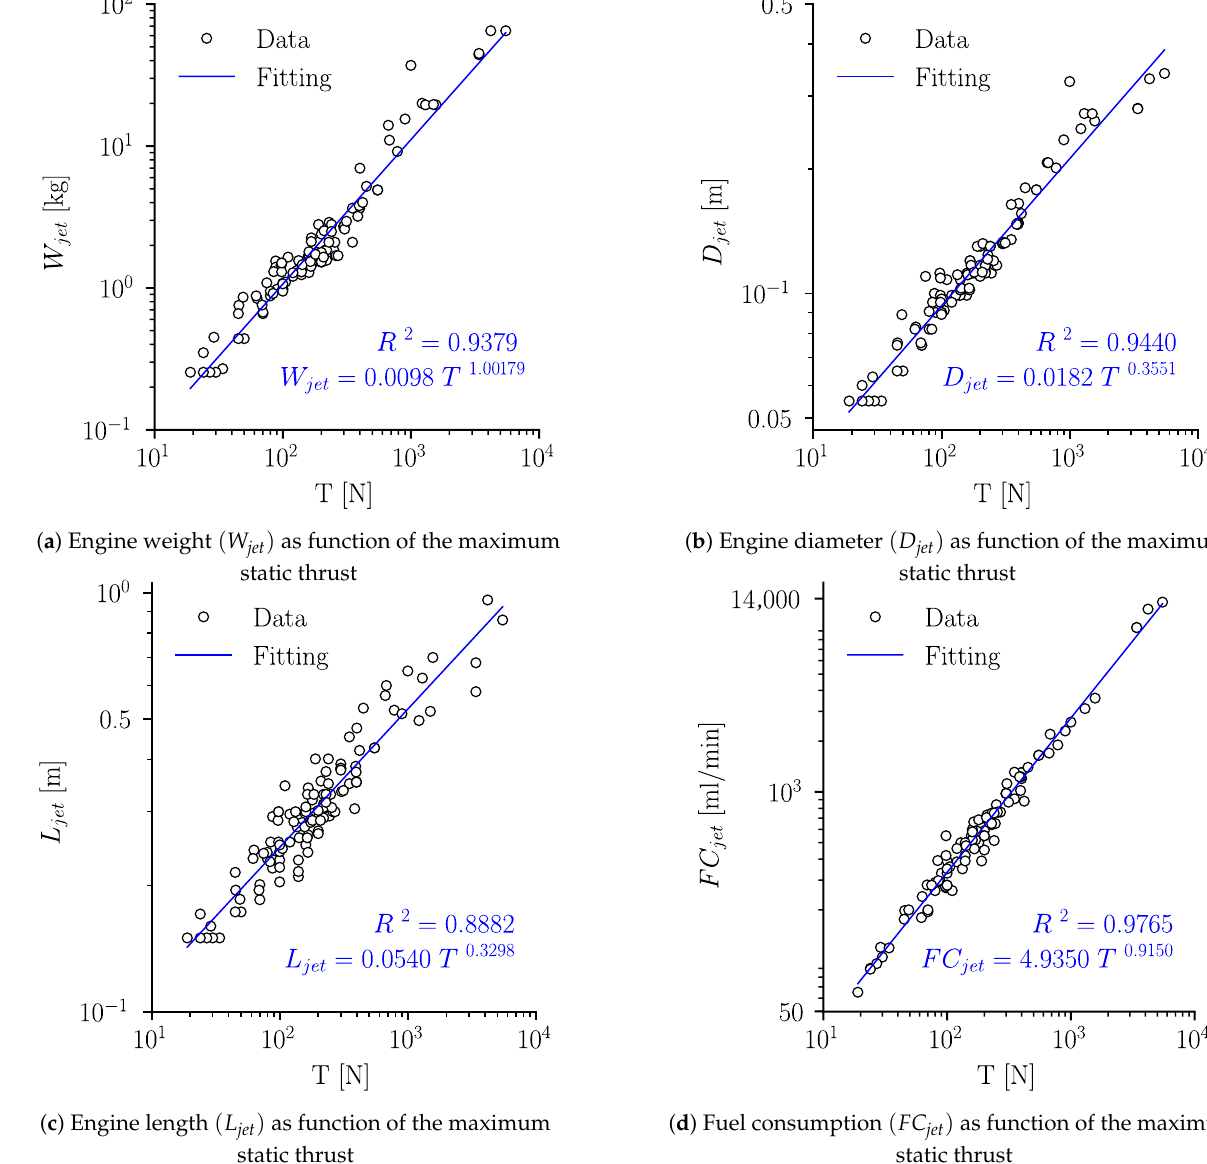
Figure 7. Sizing correlations for turbojet engines from 20 to 10,000 [N] of maximum